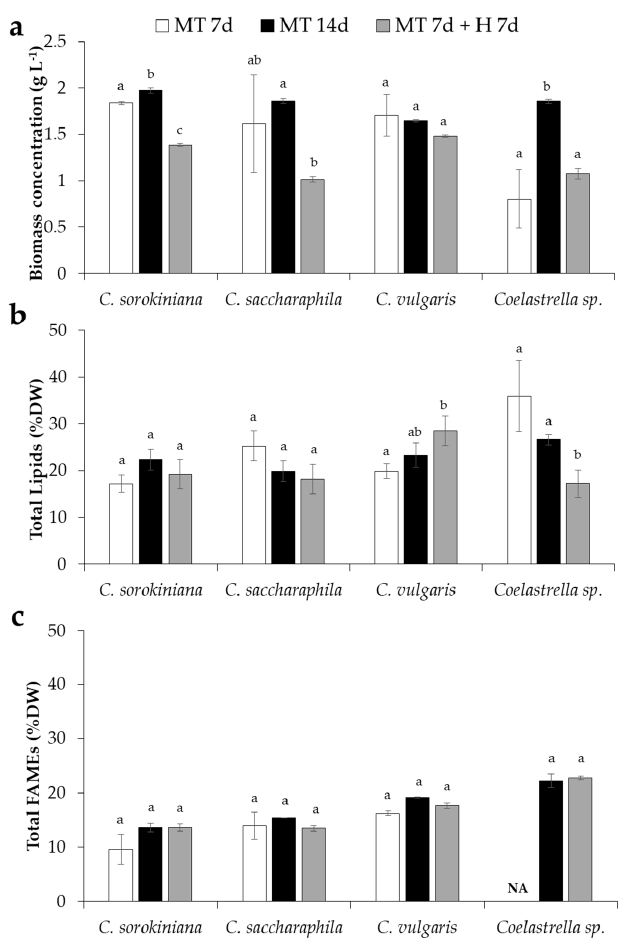
Figure 2. ( a ) Biomass concentration (g L − 1 ) ( n = 4); ( b ) total lipids (%DW) ( n = 4); and ( c ) total FAMEs (%DW) ( n = 2), of C. sorokiniana , C. saccharophila , C. vulgaris , and Coelastrella sp. grown in a birch 7 and 14 days (MT 7d and MT 14d), or mixotrophic for 7 days, and then heterotrophic for another